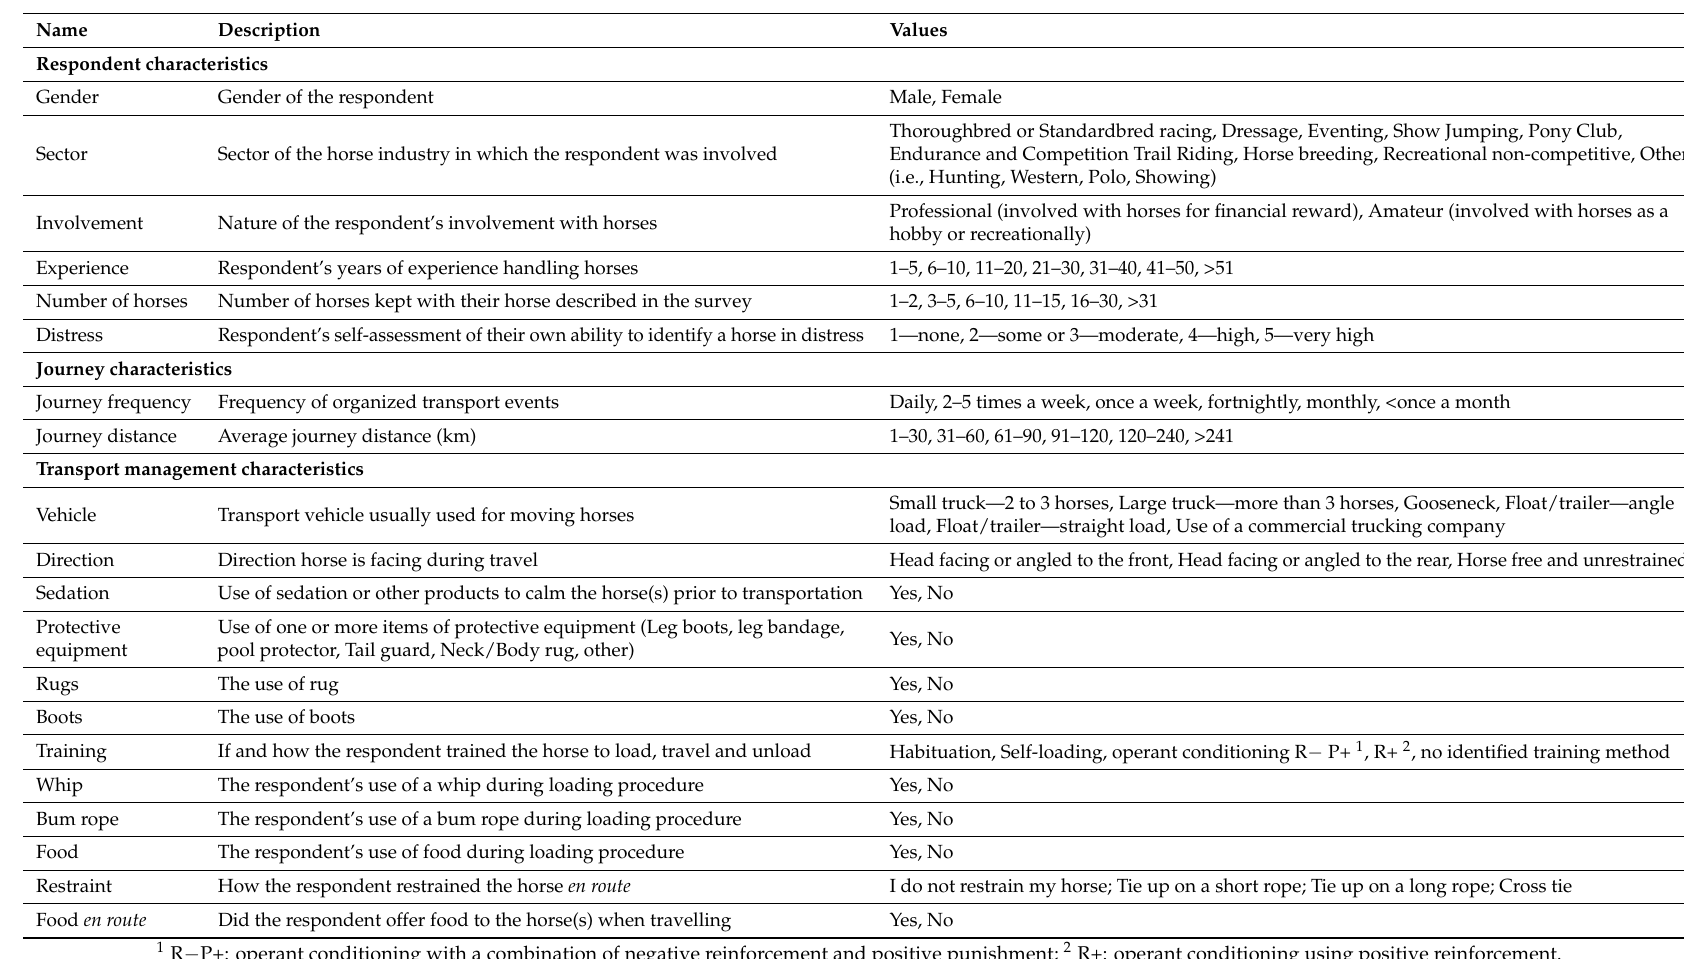
Table 1. Classification of the survey